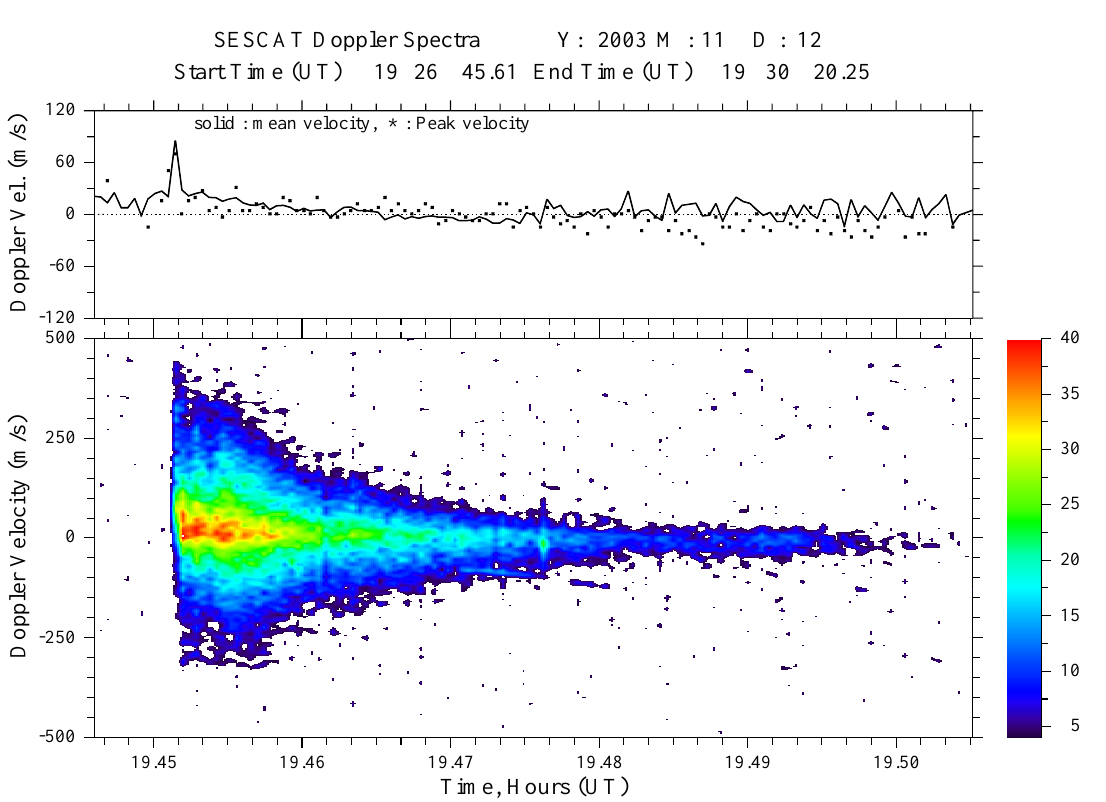
Fig. 7. A typical 50-MHz Doppler spectrogram of meteor-induced backscatter (MIB). It is characterized by an abrupt onset, and large intensities, velocities and spectrum broadening at onset. These echoes, which have lifetimes from several seconds to a few minutes, have Doppler spectra similar to those of type 2 irregularities. Although during MIB there must be very steep plasma gradients present, there is no evidence that these reduce the threshold for excitation of FB (type 1) irregularities, as predicted by